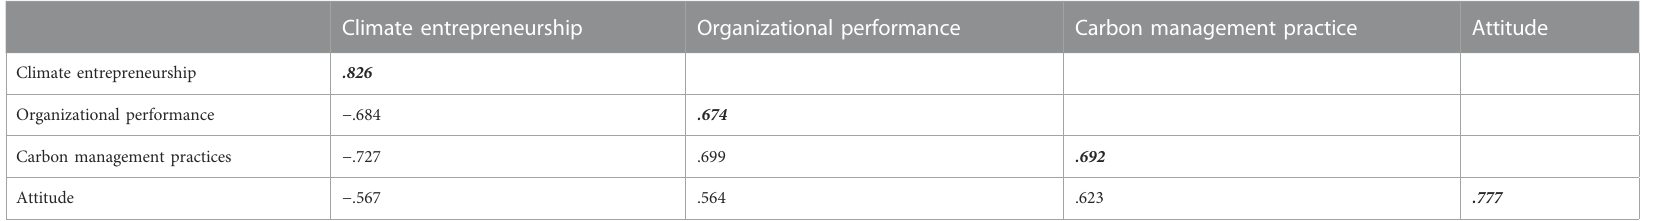
TABLE 2 Discriminant validities of variables.